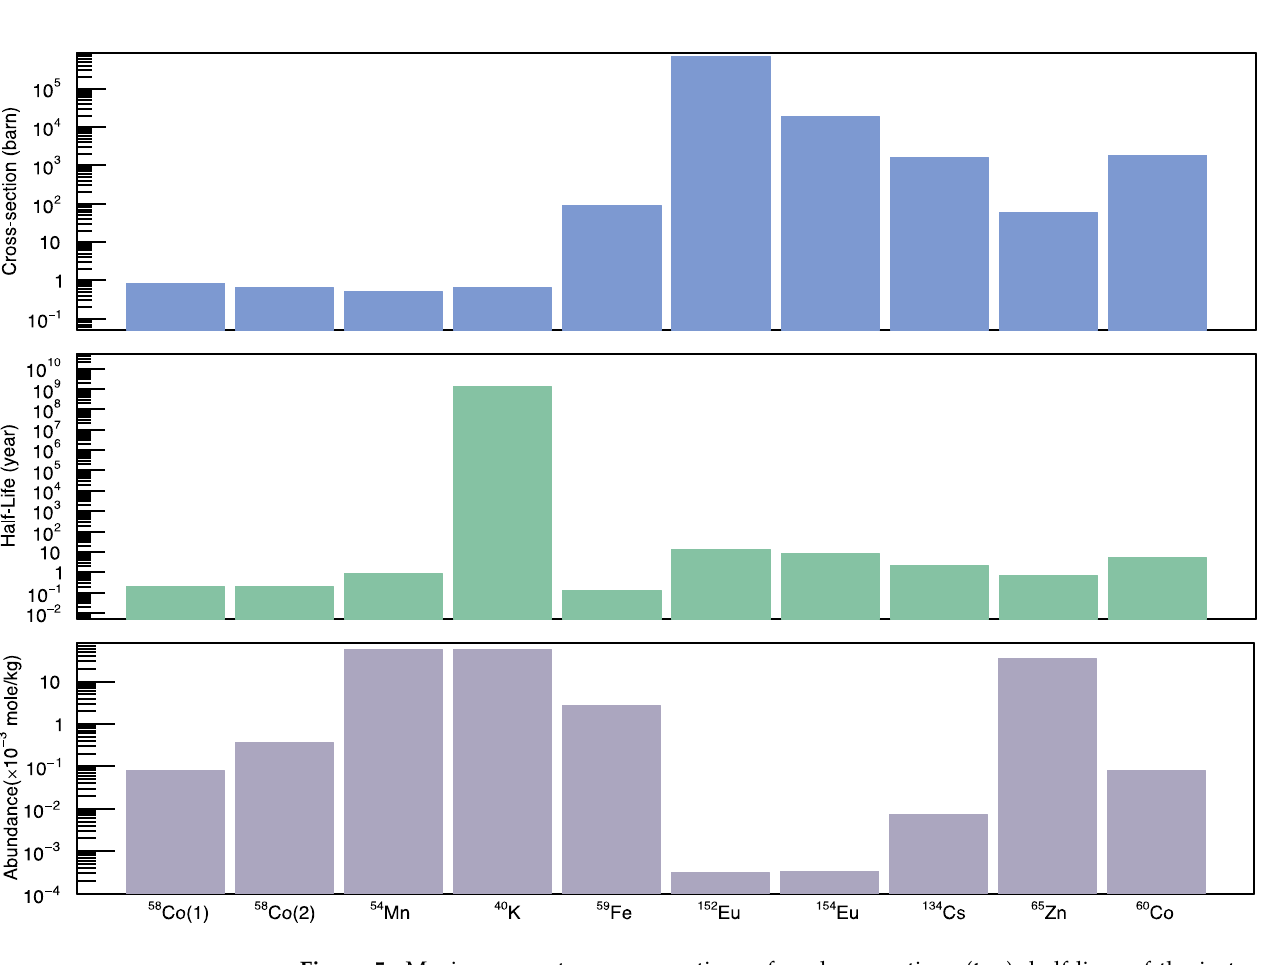
Figure 5. Maximum neutron cross-sections of nuclear reactions ( top ); half-lives of the isotopes ( middle ); and abundances of the radioactive isotopes in the wall ( bottom ).